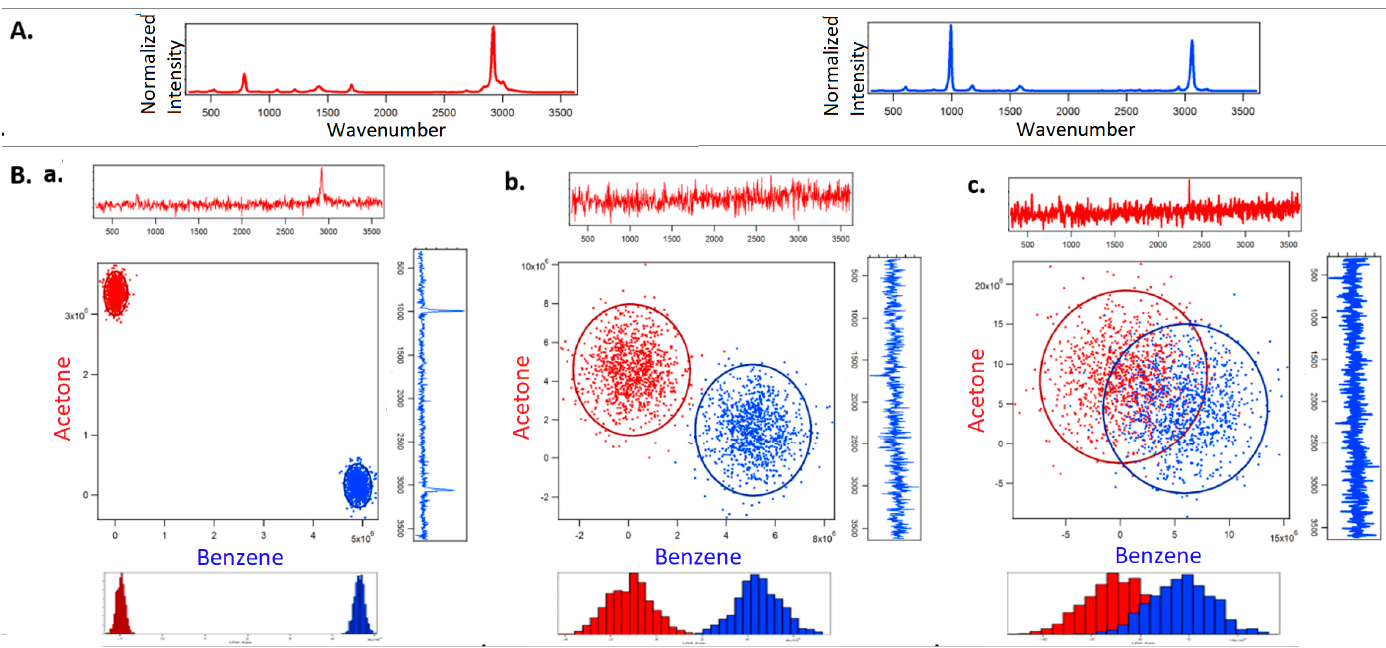
Figure 2. The figure shows the classification of acetone and benzene using a charge coupled device (CCD)-based Raman spectroscopy. Panel ( A ) shows the normalized spectra of acetone (red, top left) and benzene (blue, top right) collected using 30 mW laser power at the sample, and 1 s total spectral acquisition time to be used as training spectra in least square analysis. Subpanels ( a – c ) in Panel ( B ) correspond to the 1000 full spectral least squares classification of acetone and benzene in 1 ms using 30 mW, 3 mW, and 1 mW laser power at the sample, respectively.